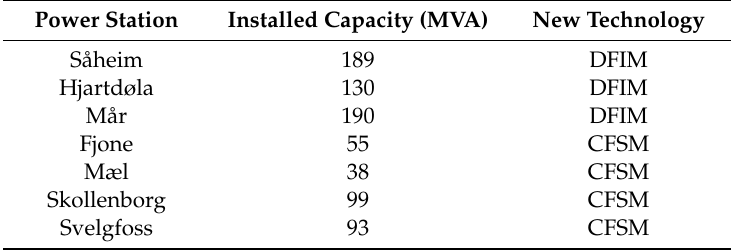
Table 6. Varied speed installations in the NPS model in the year 2040.